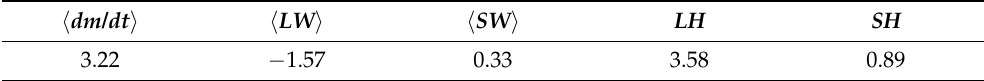
Table 2. Contributions to the total derivative of the column-integrated MSE (cid:104) dm / dt (cid:105) from hour 24 to hour 48 by different terms, long wave radiation (cid:104) LW (cid:105) , short wave radiation (cid:104) SW (cid:105) , latent heat flux LH , and sensible heat flux SH averaged between hour 48 and hour 72 (unit: 10 3 W m − 2